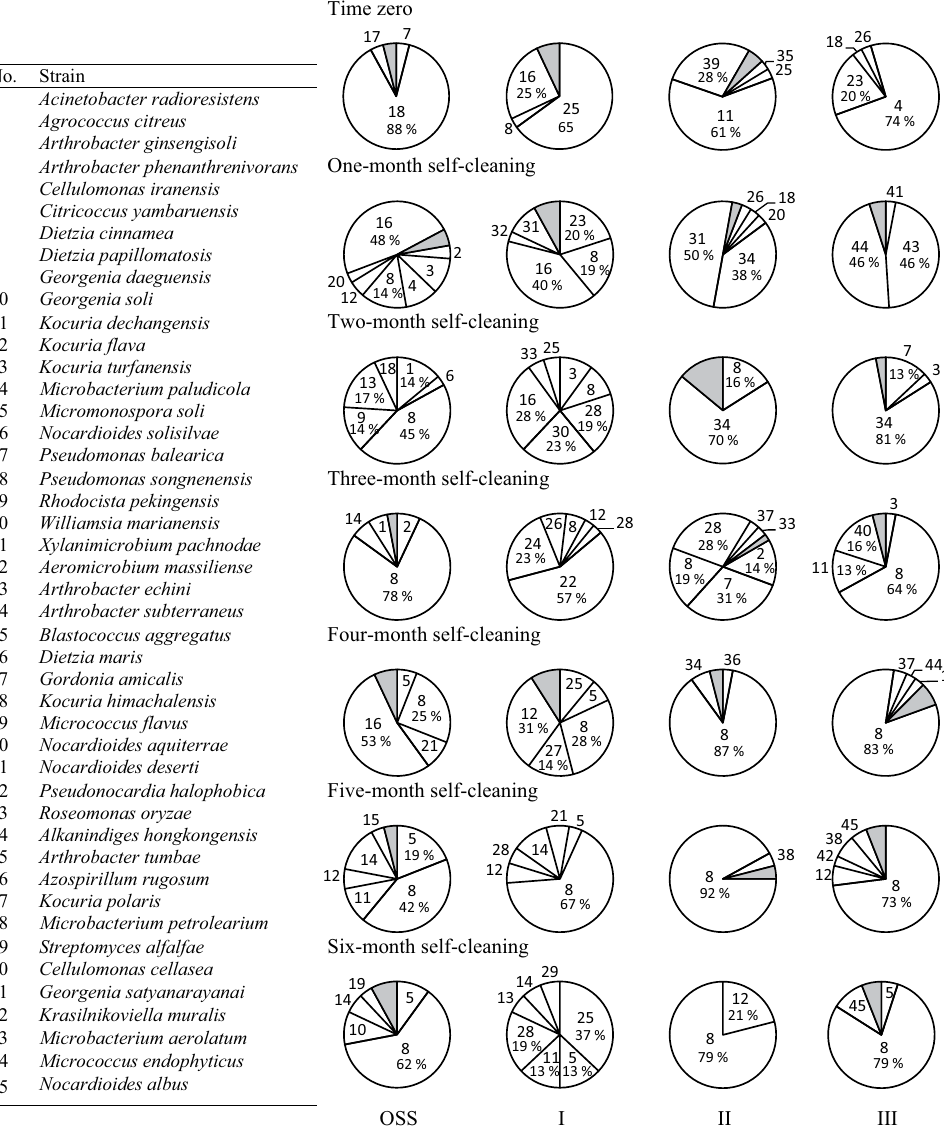
Figure 1. Dynamics of hydrocarbonoclastic microbial communities in the oil-saturated soil (OSS) and OSS diluted (with pristine desert soil: I, 1 kg OSS + 0.25 kg; II, 1 kg OSS + 0.5 kg; III, 1 kg OSS + 0.75 kg) during bioremediation. Shaded areas contain all the bacterial strains with ≤ 2% occurrence. For minor organisms in the shaded areas, refer to Supplementary Table